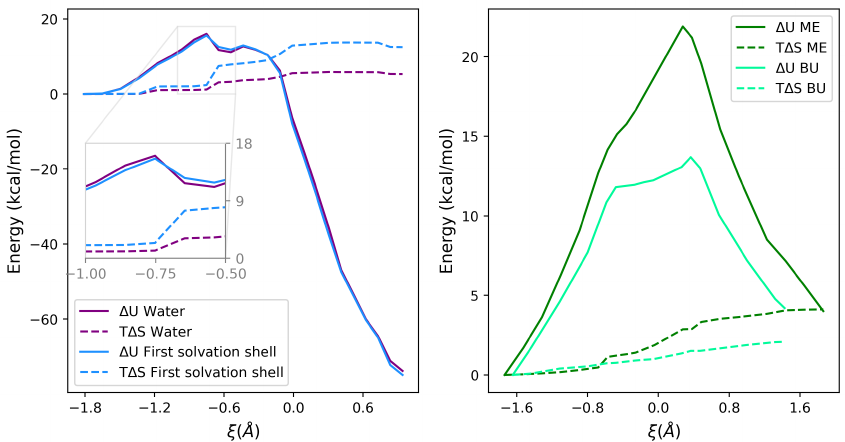
Figure 4. Comparison of the internal energy and entropy variations in different perturbing environ- ments. ( Left panel : Met oxidation; Right panel : thiol/disulfide interchange reaction for ME (water) and BU